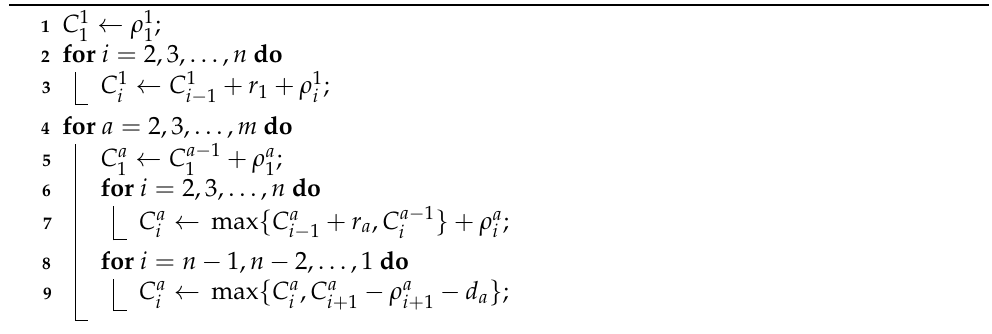
Algorithm 1: Constructing left-shifted schedule C from the solution